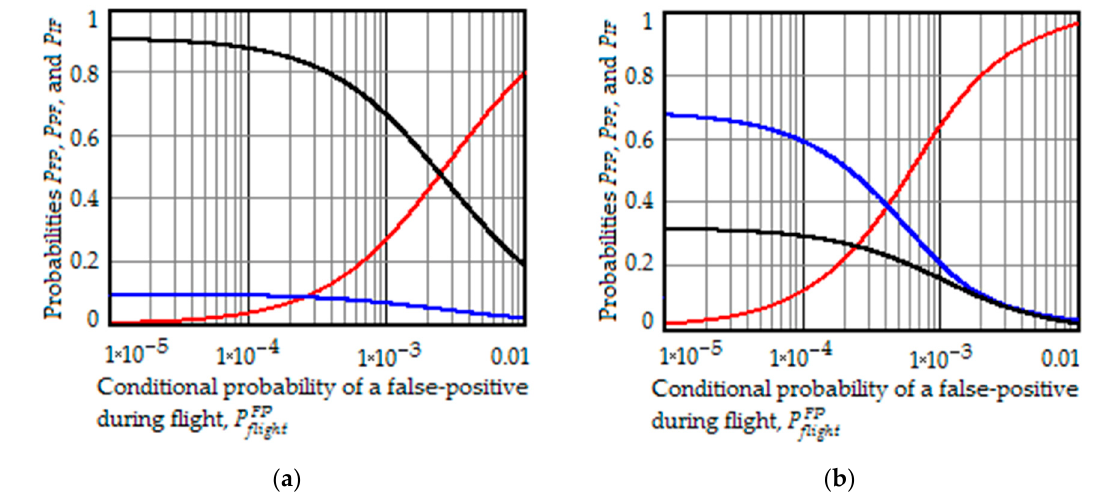
Figure 6. Dependences of the posterior probabilities of dismounting the LRU due to the in-flight false-positive (red curve), intermittent fault (black curve), and permanent failure (blue curve) on the conditional probability of in-flight false-positive when λ = 10 − 4 h − 1 ; ( a ) θ = 1 × 10 − 3 h − 1 ; ( b ) θ = 1 × 10 − 4 h − 1 .